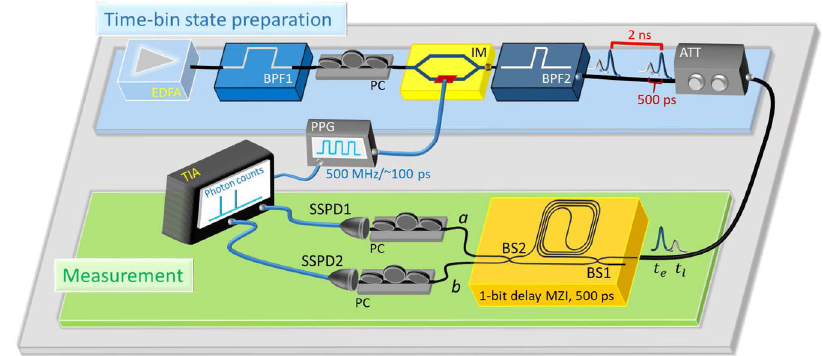
i (cid:3) j 0 i , where there is a single photon at the early time bin t e and no t l e